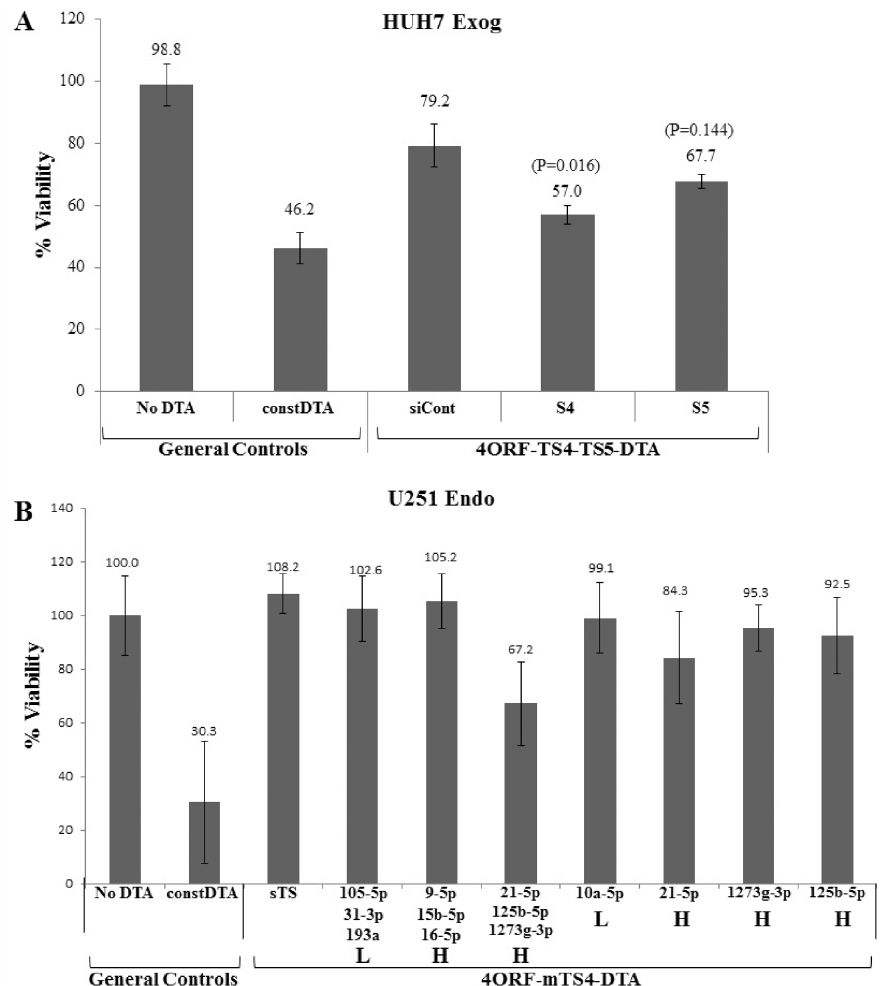
Fig. 8. Decrease in cell viability by siRNA and miRNA dependent induction of DTA. U251 cells were transfected with the indicated construct (50 ng) with (A) or without (B) siRNAs (10pmol). Cell viability was determined by an XTT assay. The XTT viability value of the ‘‘No DTA’’ construct was set as 100% and the viability value obtained for all other constructs were compared to the No DTA level. (A) DTA dependent decrease in cell viability induced by siRNA in HUH7 cells. The siRNA used were: siCont: control siRNA; S4: siRNA S4; S5: siRNA S5. The numbers above the bars indicated the % viability obtained with each siRNA. P- values are indicated for the specific siRNAs. (B) DTA dependent decrease in cell viability induced by miRNA in U251 cells. The ‘‘Const DTA’’ construct had no UIR, with the DTA transgene directly driven by the CMV promoter. Each bar on the X-axis stands for a construct containing different TS region. The ‘‘sTS’’ control was the 4ORF construct with target sites for siRNAs S4 and S5. The miRNAs for which fully matched target sites were included in the TS are indicated below the bars. The relative level of expression of the miRNAs in the cells (see Table 2) are marked as L (Low) or H (High). The numbers above the bars of the siRNA indicated the % viability obtained with each siRNA. The experiments were repeated 3 and 4 times, respectively, for A and B. Each experiment was done in triplicates. Statistical analysis was done by T-test and the bars represent standard error. P value for the construct with target sites for miRNAs 21-5p, 125b-5p, 1273g-5p was 1.2*e( 2